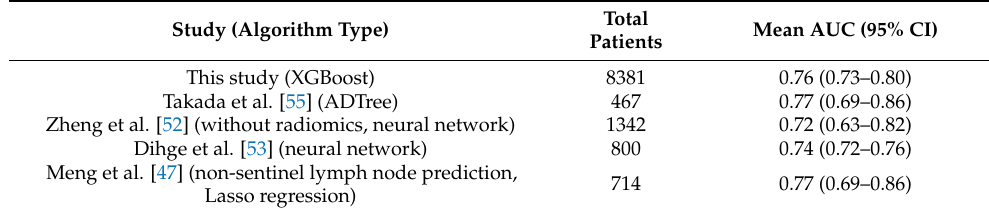
Table 5. Comparison with other studies that used clinicopathological features for breast cancer lymph node